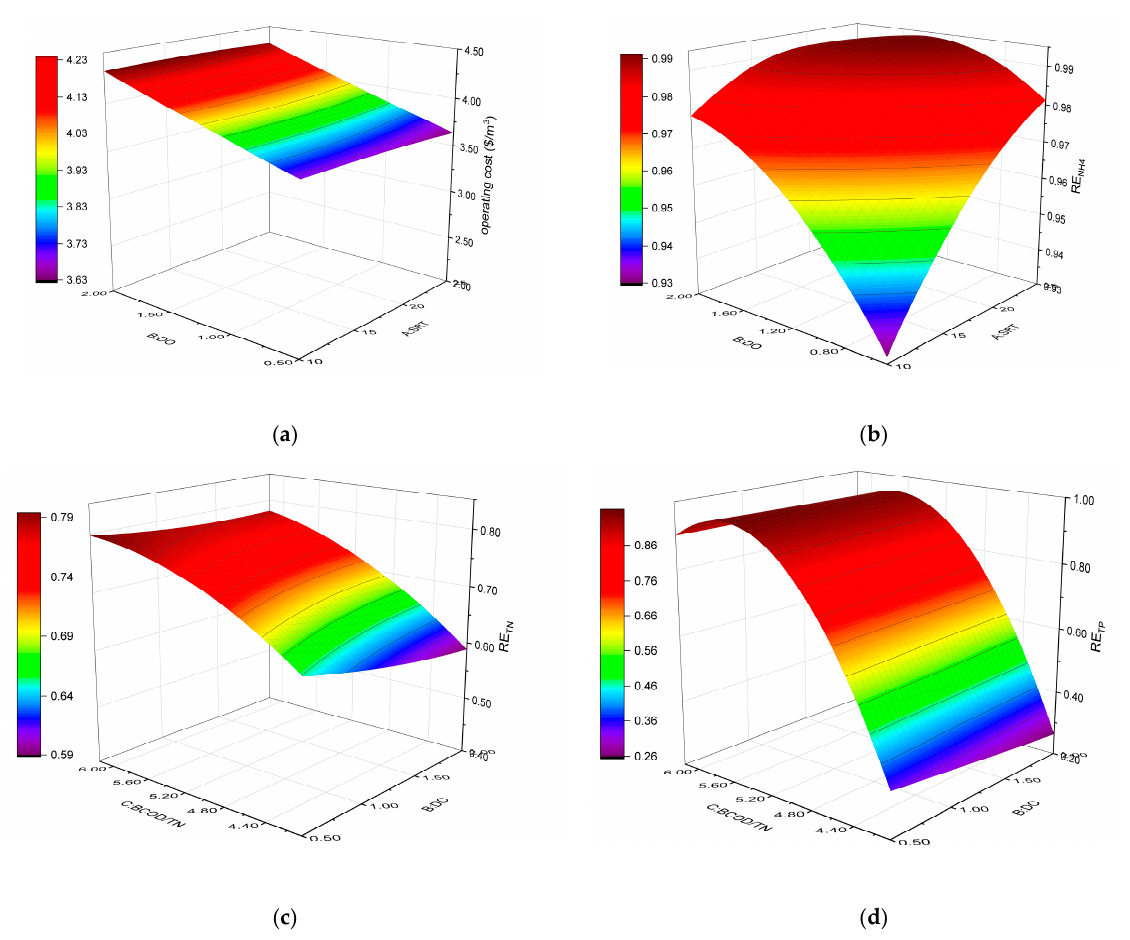
Figure 4. Response surface curves and contour maps of the quadratic models for ( a ) the operating cost and removal efficiencies of ( b ) NH 4+ -N, ( c ) TN, and ( d ) TP. Actual factors are as follows: ( a ) BCOD/TN = 5.05; ( b ) BCOD/TN = 5.12; ( c ) SRT=15 d; ( d ) SRT = 15 d.